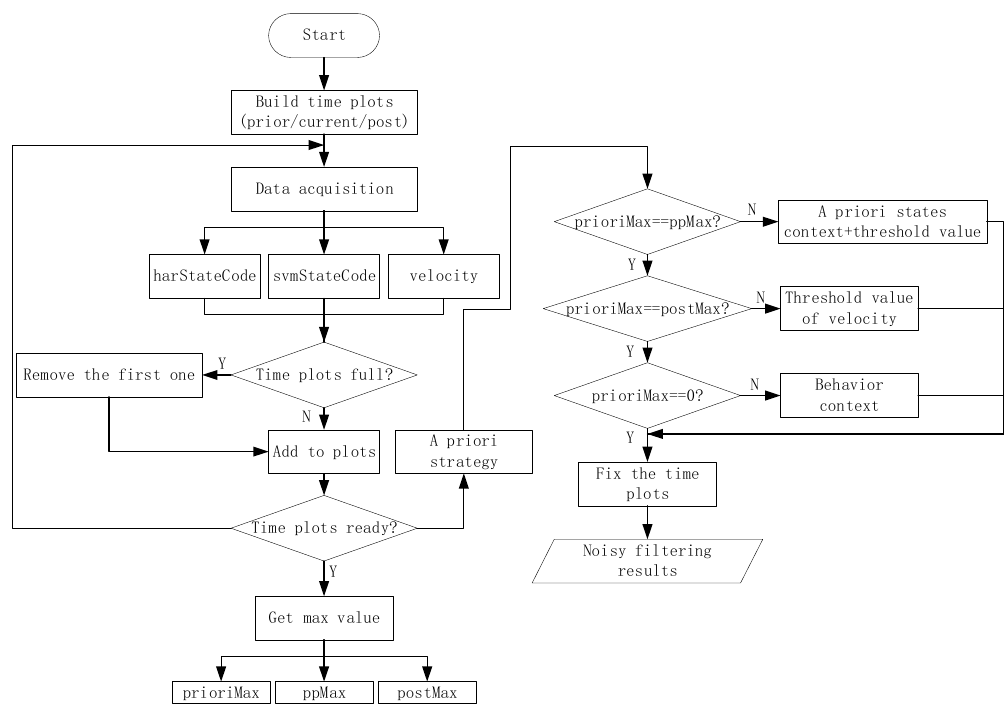
Figure 5. Circumstances of a certain state.